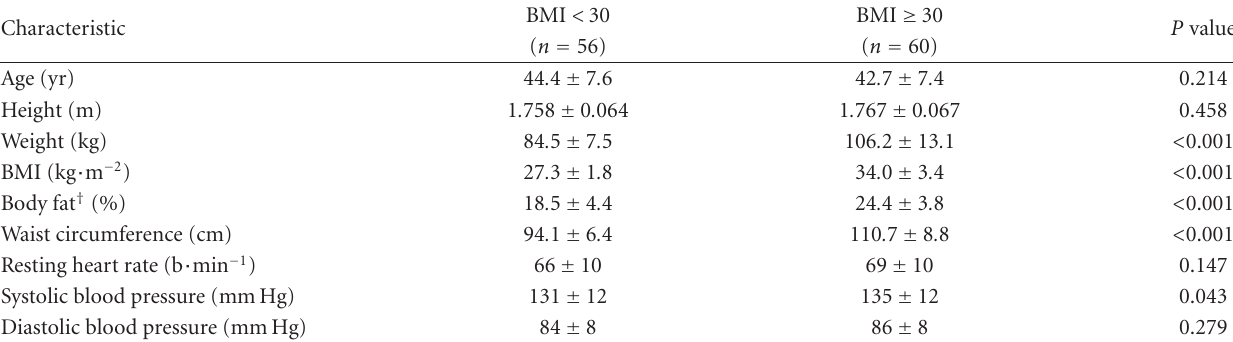
Table 1: Participant descriptive characteristics (mean ± SD).